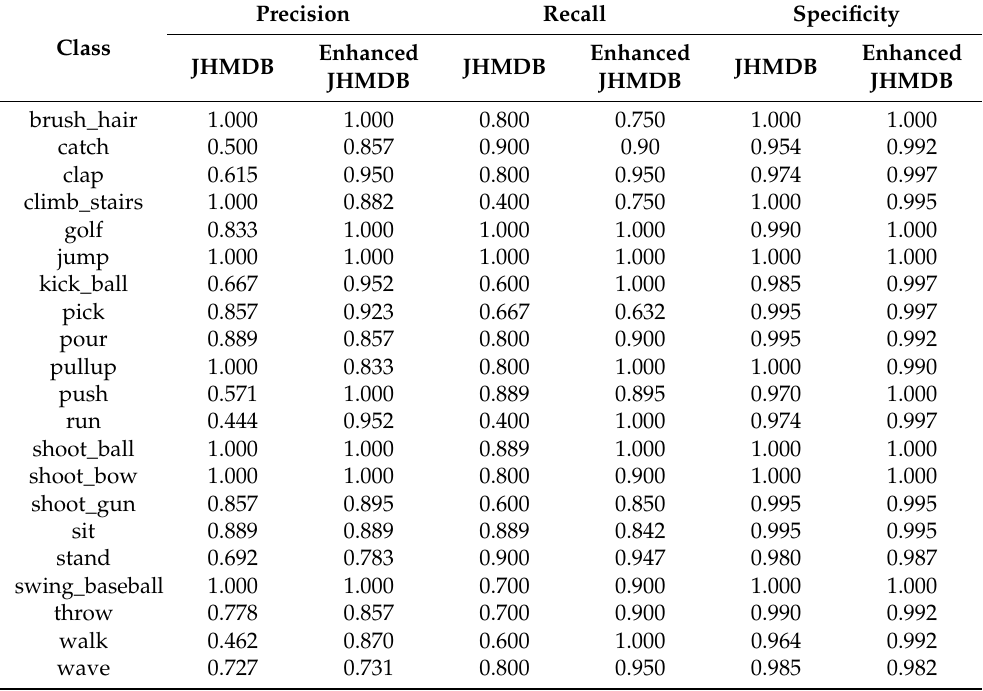
Table 4. Comparison of indicators before and after flipping enhancement of the JHMDB dataset.